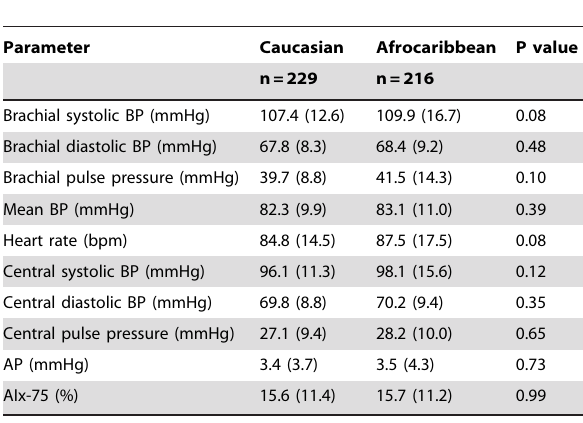
Table 3. Hemodynamic parameters in Caucasian and Afrocaribbean